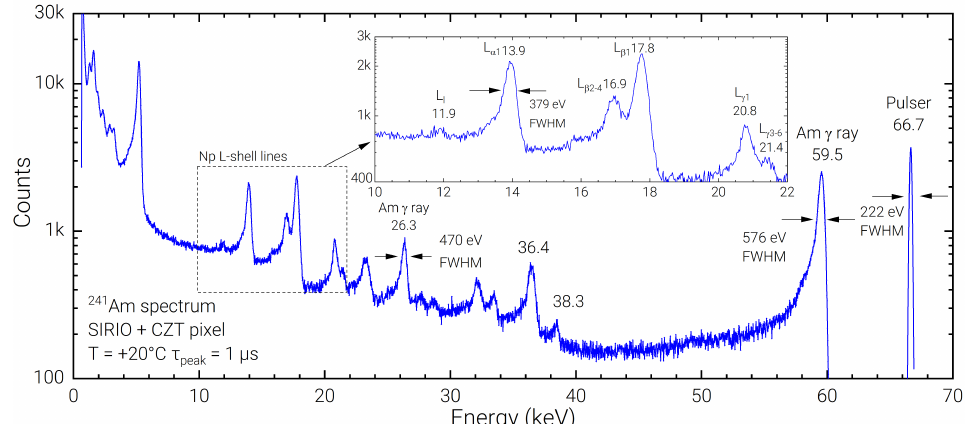
Figure 5. Best room temperature spectrum of a 241 Am source acquired using Amptek PX5 DPP at the optimum peaking time of 1 µs.